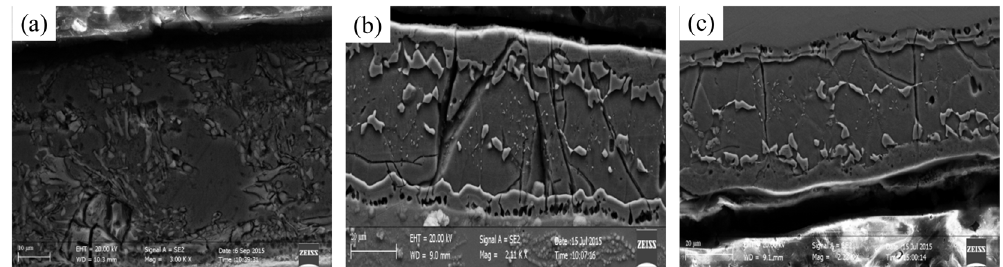
Figure 5: SEM micro - structure of coatings: ( a ) hot - dip coating, ( b ) hot stamping coating with forming radius of 2 mm, and ( c ) hot stamping coating with forming radius of 4 mm.